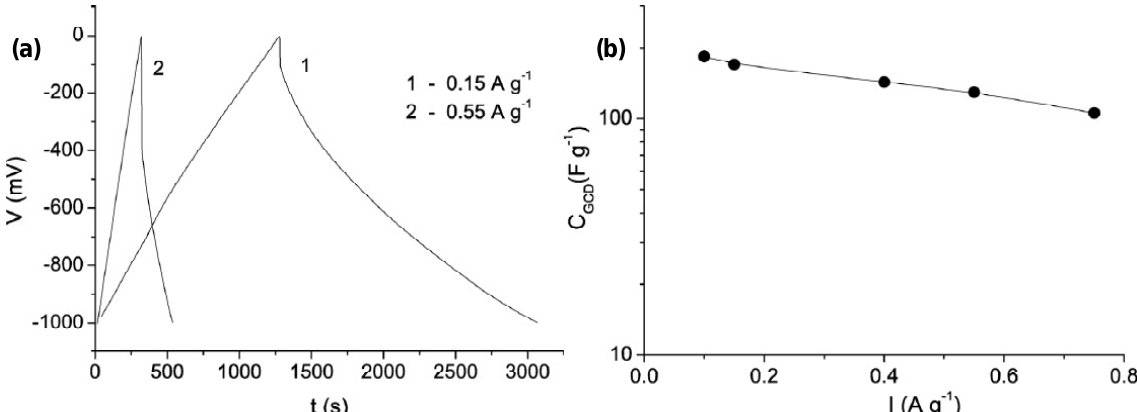
Fig. 7. Electrochemical testing results for monolithic activated biocarbon bioC_31: a) galvanostatic charge- discharge curves at various current densities; b) specific capacitance as a function of current density, based on the charge–discharge curves (1 M KOH electrolyte).